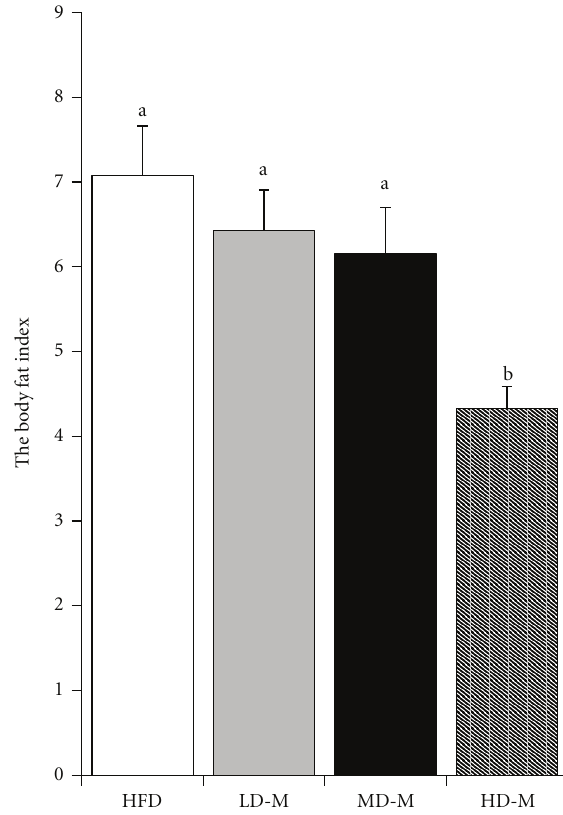
Figure 1: Total fat masses were measured after 6-week dietary treatments in rats. Bars represent means ± standard errors, n = 10. ab Means not sharing a common letter are significantly di ff erent among groups at P < 0 . 05.